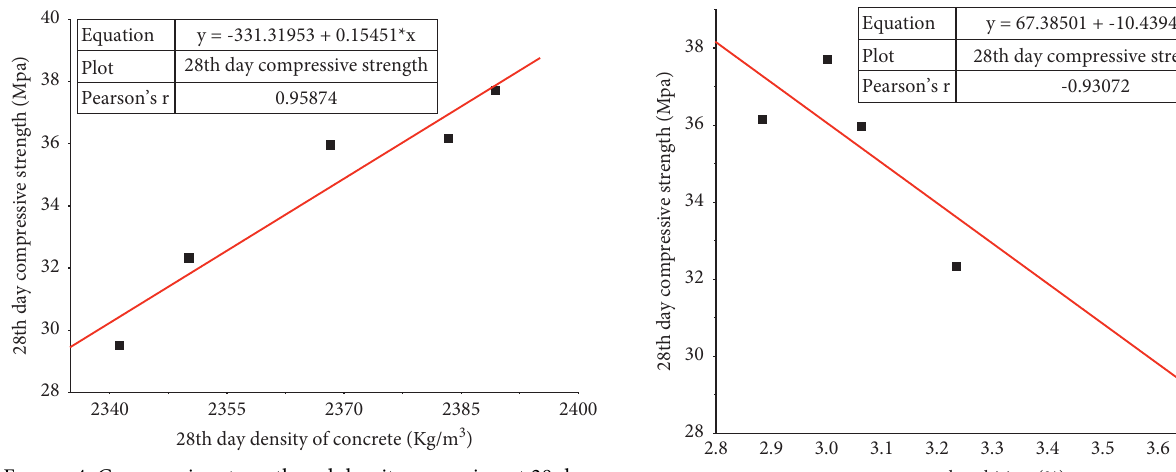
Figure 4: Compressive strength and density regression at 28 days.